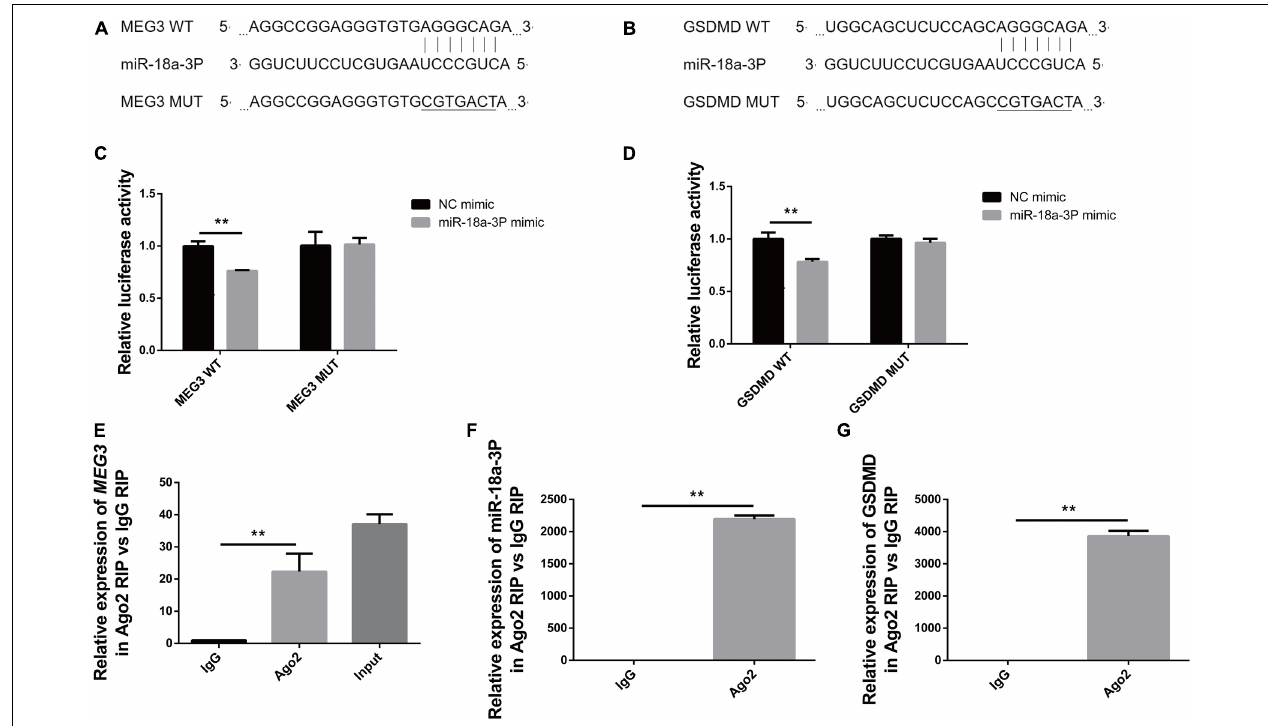
FIGURE 7 | MEG3 directly binds to miR-18a-3p, and miR-18a-3p directly binds to GSDMD. (A) Binding and mutation sites of MEG3 and miR-18a-3p bases. (B) Binding and mutation sites of miR-18a-3p and GSDMD bases. (C) Dual-luciferase activity of MEG3 and miR-18a-3p. (D) Dual luciferase activity of miR-18a-3p and GSDMD. (E) Relative expression of MEG3 in RIP assay. (F) Relative expression of miR-18a-3p in RIP assay. (G) Relative expression of GSDMD in RIP assay. ** P < 0.01, compared with the respective control